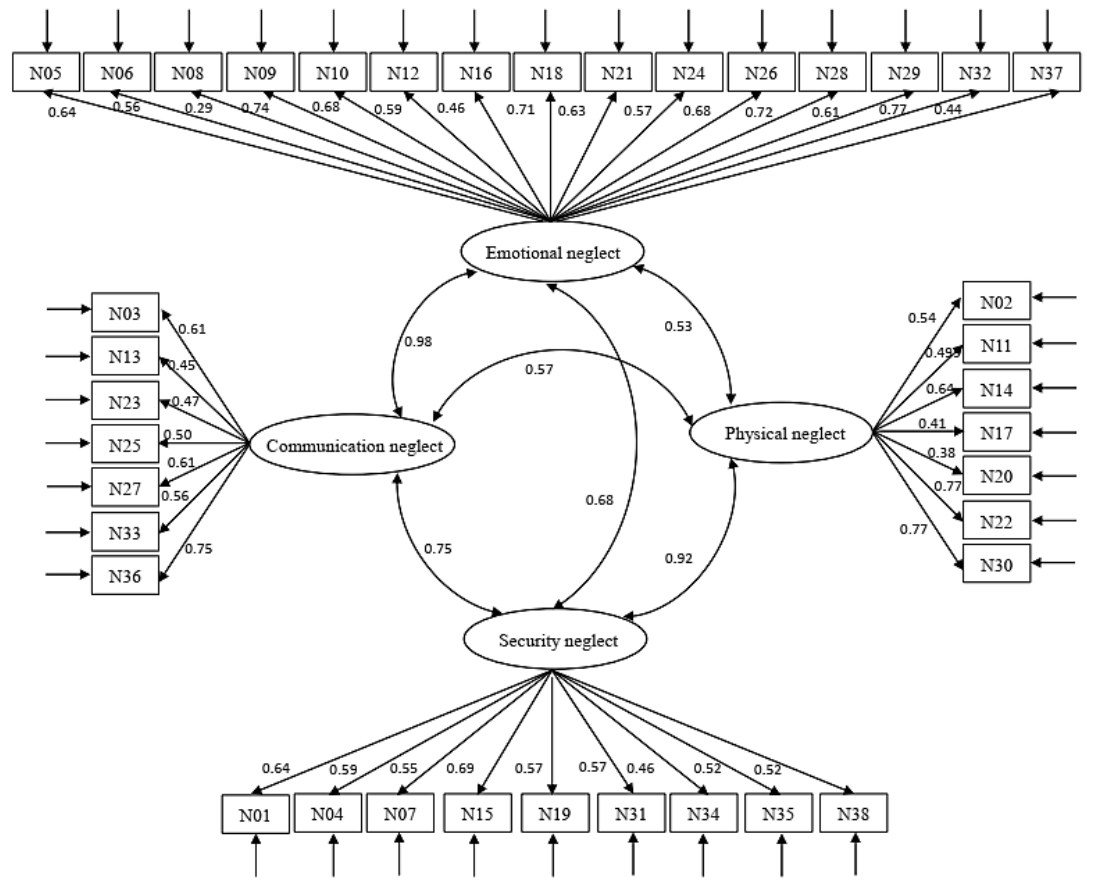
Figure 1. Model testing of the confirmatory factor analysis. Table 5. Confirmatory factor analyses (n = 212).